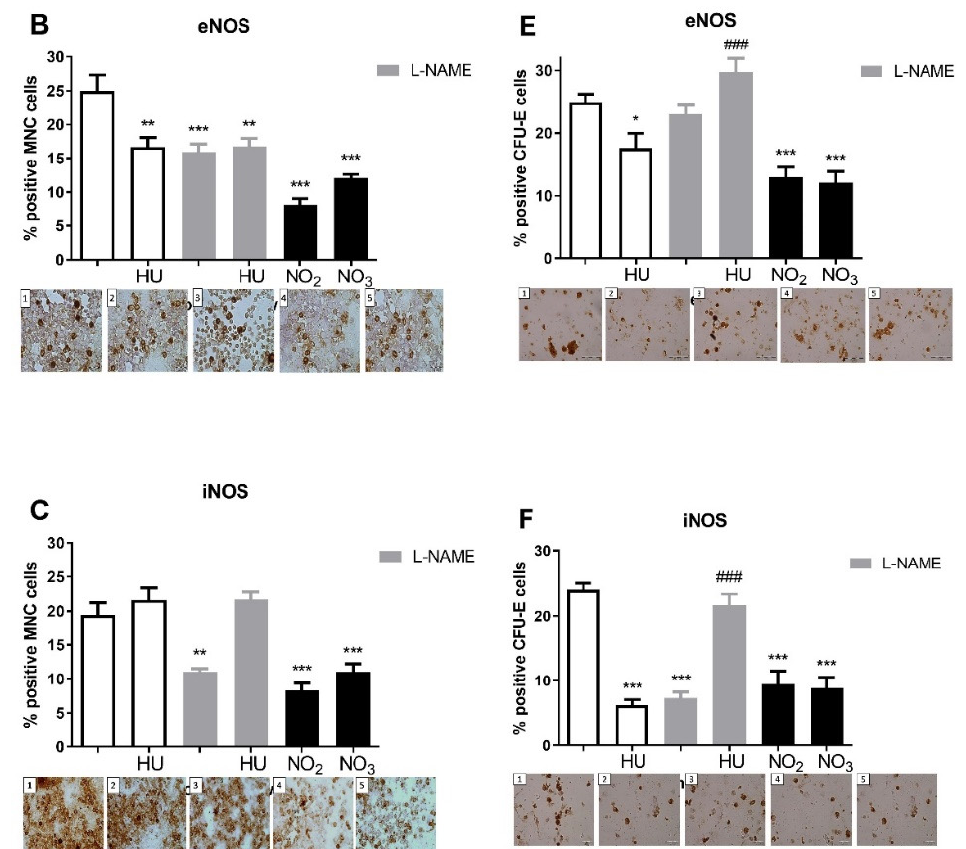
Figure 6. NOS levels in mouse bone marrow derived mononuclear cells (MNC) and erythroid progenitors. Frequency of ( A ) nNOS, ( B ) eNOS, and ( C ) iNOS positive MNC ( n = 10), ( D ) nNOS positive cells of BFU-E/CFU-GM colonies, ( E ) eNOS, and ( F ) iNOS positive cells of CFU-E colonies ( n = 5) of mice in vivo treated with hydroxyurea (HU, 200 mg/kg), sodium nitrite (NO 2 , 1 mmol/kg), and sodium nitrate (NO 3 , 1 mmol/kg) with or without L-NG-Nitroarginine methyl ester (L-NAME, 50 mg/kg). Columns correspond to immunocytochemistry images, except for the L-NAME only treatment. Values are mean ± SEM. * p < 0.05, ** p < 0.01 and *** p < 0.001 vs. non-treated mice; ## p < 0.01 and ### p < 0.001 vs. HU only treated